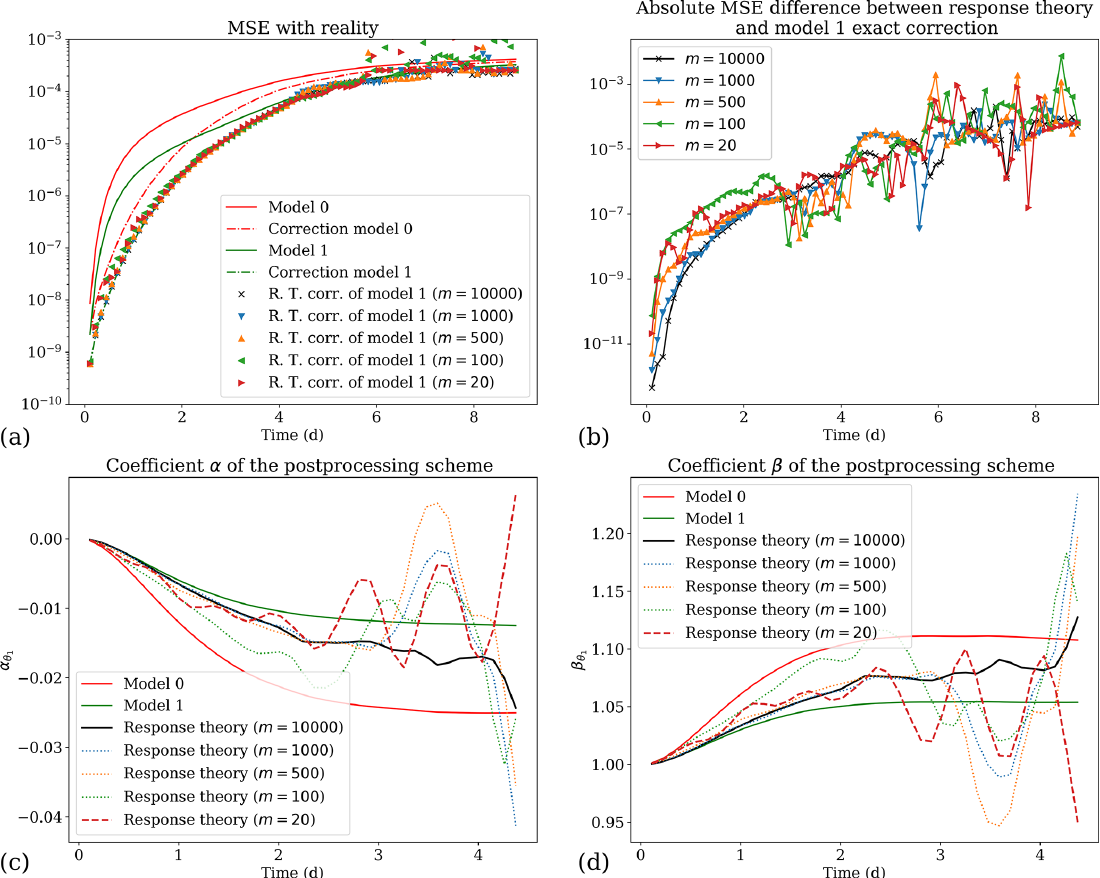
Figure 11. Comparison of the efficiency of the response-theory correction for different numbers m of trajectories used to average Eq. (49), for the experiment of varying the friction coefficient: (a) mean square error with reality, (b) absolute difference between the response-theory correction and the correction based on the forecast of model 1, and (c, d) postprocessing coefficients α and β . In panels (b) , (c) and (d) , the higher (100000) and the lower (20) numbers are depicted respectively by a solid black line and a dashed red line. The other cases in between are depicted by dotted